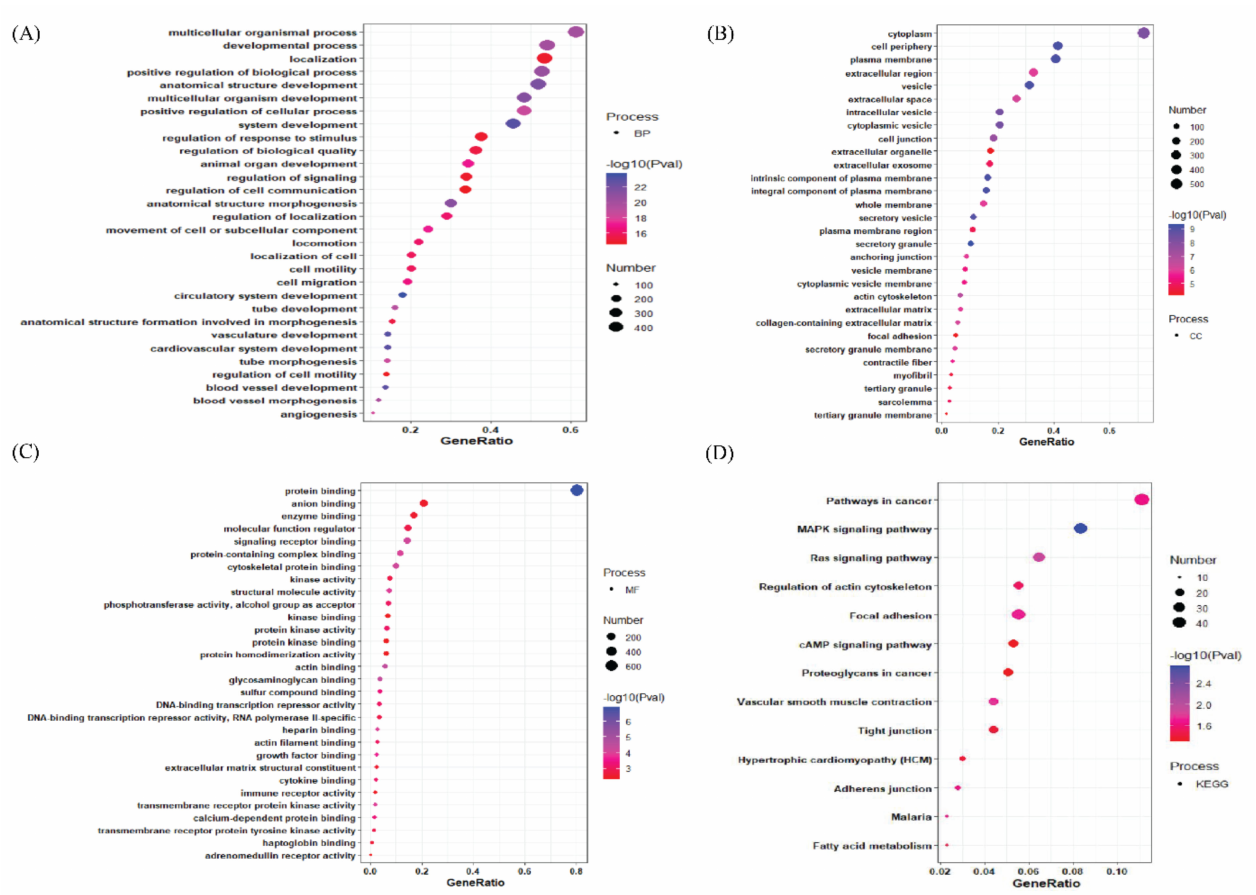
Figure 4. The gene enrichment analysis ( A ) The downregulated DEGs’ top30 enriched GO terms with logFC > |0.1| for each of the biological processes (BP). ( B ) The downregulated DEGs’ top30 enriched GO cellular component (CC). ( C ) The downregulated DEGs’ top 30enriched GO molecular function (MF). ( D ) The downregulated DEGs’ top30 enriched GO KEGG pathway (KP). Gene Ratio is defined as the ratio between intersection size and query size. The number refers to interaction size, i.e., the number of genes corresponding to an ontology